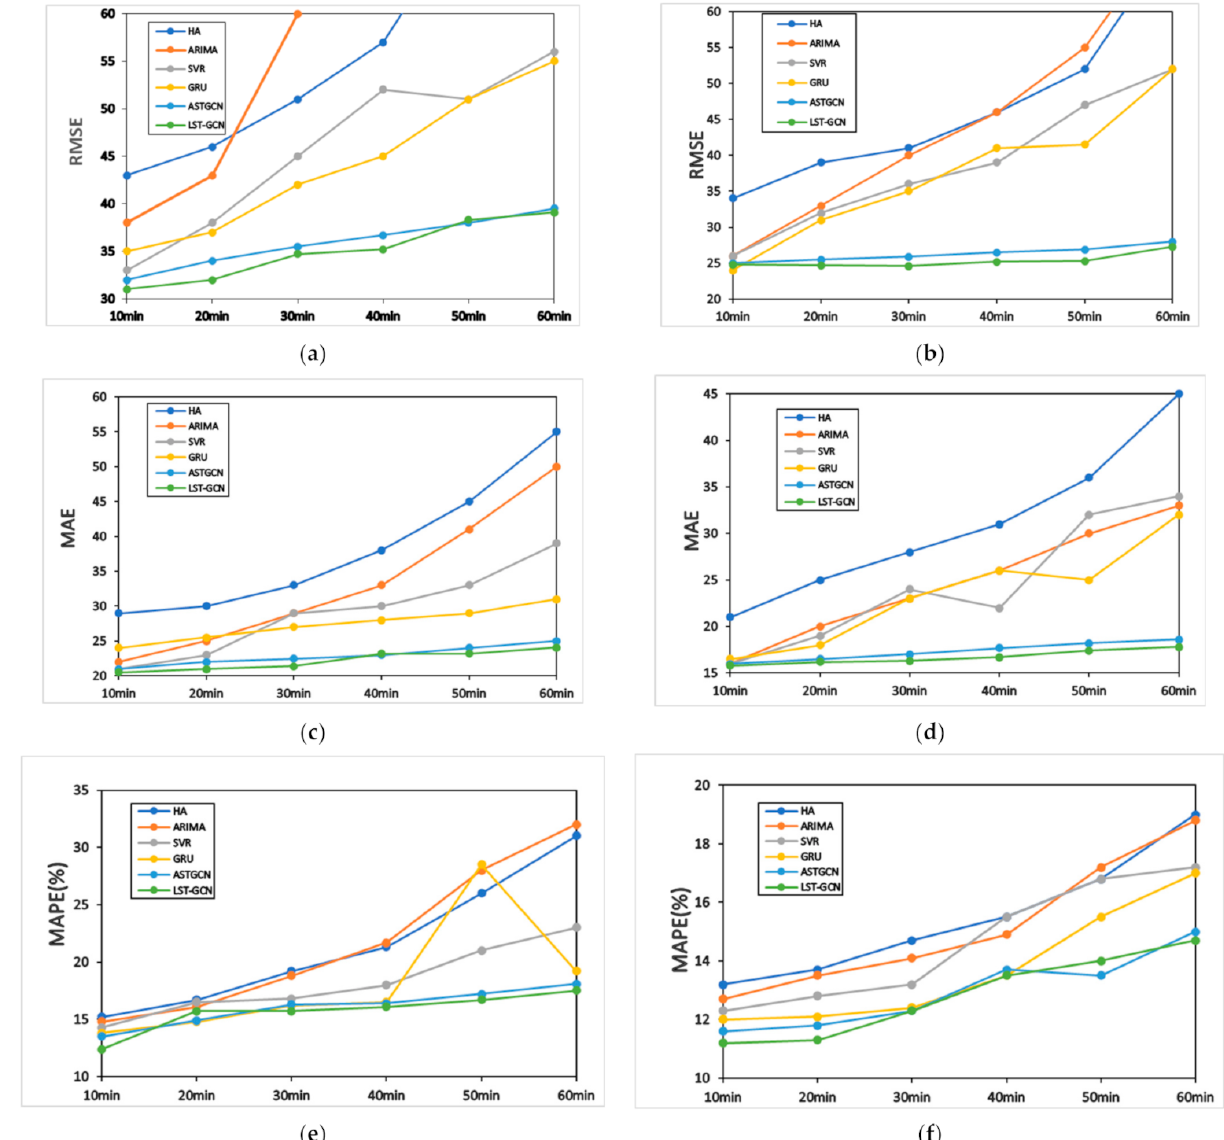
Figure 7. Performance changes of different methods as the forecasting interval increases. ( a ) Changes on PEMS04 dataset, based on RMSE. ( b ) Changes on PEMS08 dataset, based on RMSE. ( c ) Changes on PEMS04 dataset, based on MAE. ( d ) Changes on PEMS08 dataset, based on MAE. ( e ) Changes on PEMS04 dataset, based on MAPE. ( f ) Changes on PEMS08 dataset, based on